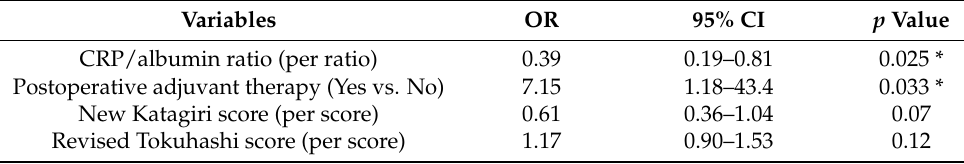
Table 4. Multivariate analysis of predictors of survival >6 months after palliative surgery.